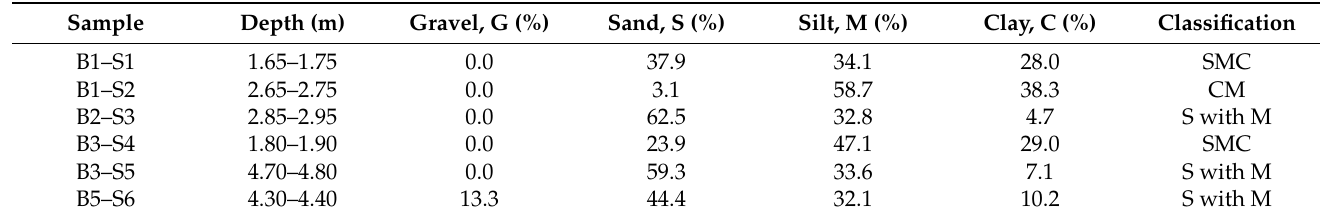
Table 1. Particle size distribution with classification for the six analysed samples.